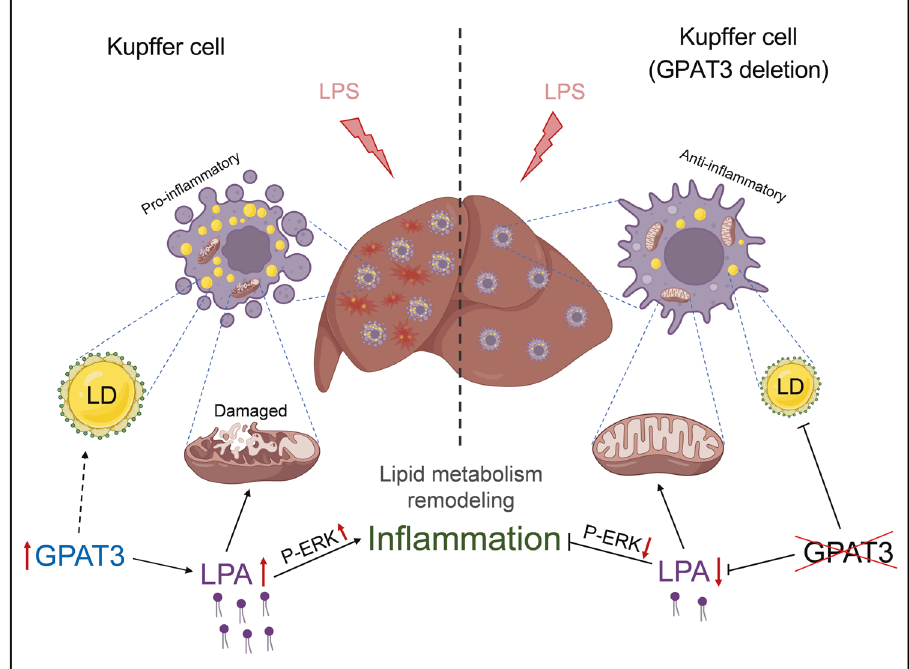
Fig. 7 Graphical abstract. LPS induced Kupffer cells lipid metabolism remodeling and high GPAT3 expression. GPAT3 plays a critical role in the pro-in fl ammatory response and mitochondrial function by regulating the synthesis of LPA and up-regulate P-ERK signaling